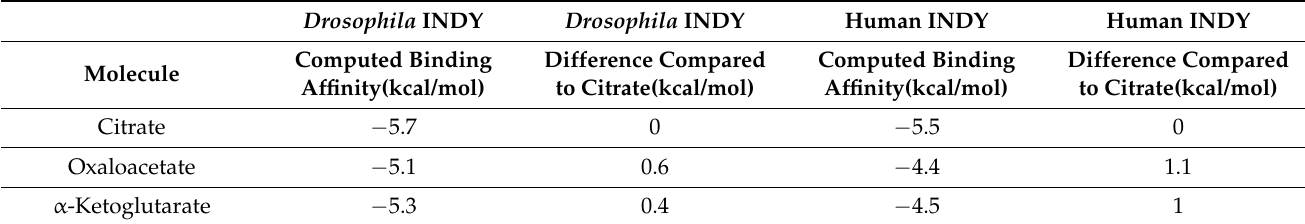
Figure 5. Close-up view of proposed binding sites for citrate and α -ketoglutarate in human INDY and Drosophila INDY. Na + ions are shown as purple spheres; citrate (yellow) and α -ketoglutarate (magenta) are shown as sticks. Table 1. Computed binding affinities for citrate and dicarboxylates (oxaloacetate and α -ketoglutarate) in Drosophila INDY and human